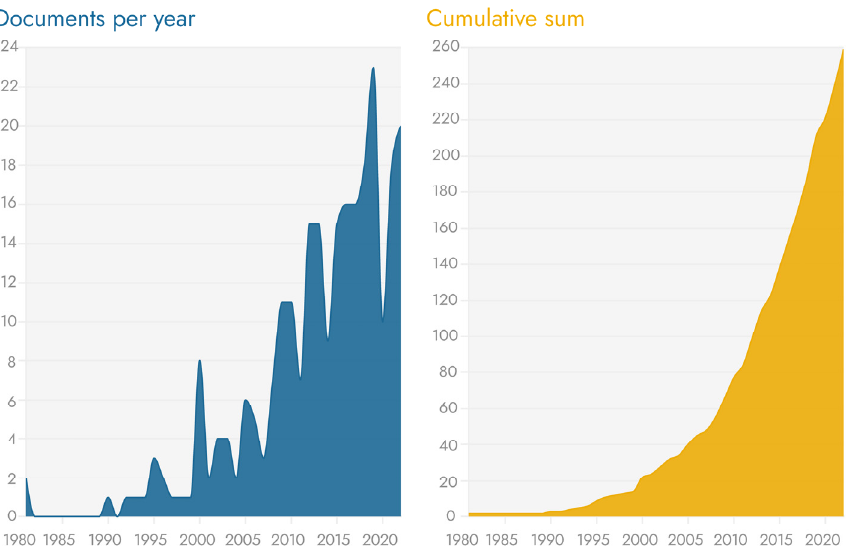
Figure 3. Evolution over time of the relevant literature.